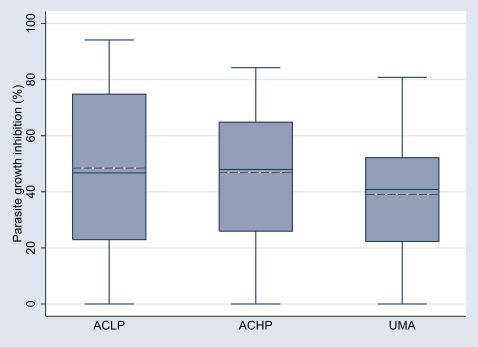
Parasite growth inhibitory capacity of purified IgG in groups segregated according to malariometric status.Data from IgG purified from a total of 75 plasma samples is illustrated for groups of children segregated according to their status as either low (ACLP, <2500 parasites/ul) or high (ACHP, ≥2500 parasites/ul) asymptomatic parasitemia carriers, or those with one or more malaria attacks (UMA, parasitemia plus fever) during 12 months' follow-up. 15 samples (5 matched trios) were excluded due to large variations between triplicate samples (coefficient of variation >30%). Box-whisker plots represent medians with 25th and 75th percentiles (boxes), and with 10th and 90th percentiles (whiskers), outliers as discrete dots. Doted lines represent the arithmetic mean of parasite growth inhibition.